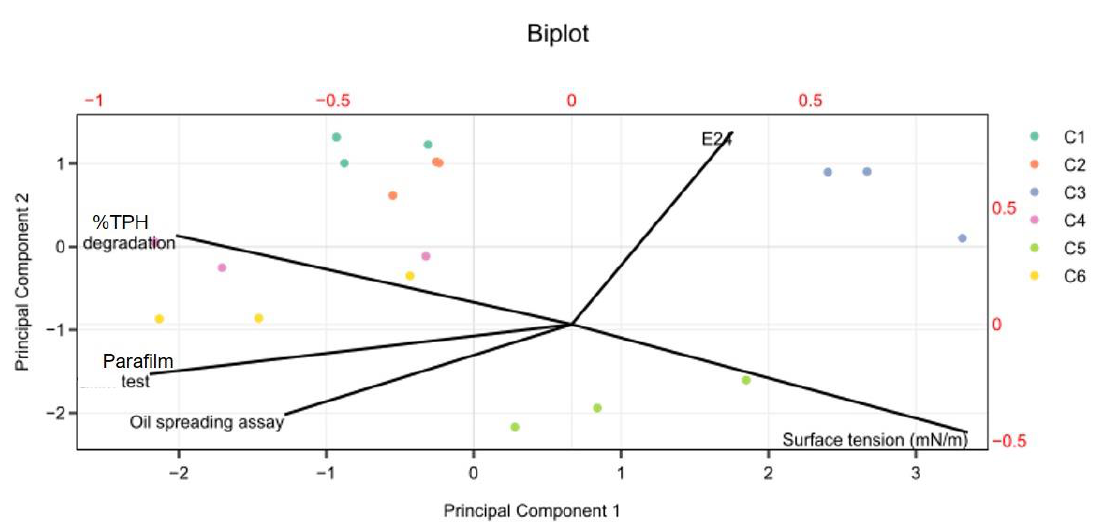
Figure 6. Principal component analysis (PCA) biplot depicting the relationship between the percentage of TPH degradation by six different consortia, surface tension reduction, and some qualitative and indirect assay for biosurfactant measurements. Data visualization analyzed with software BioVinci by BioTuring. Note: Solid circles represented the six consortia. Arrows indicate the direction variables associated with the consortia.